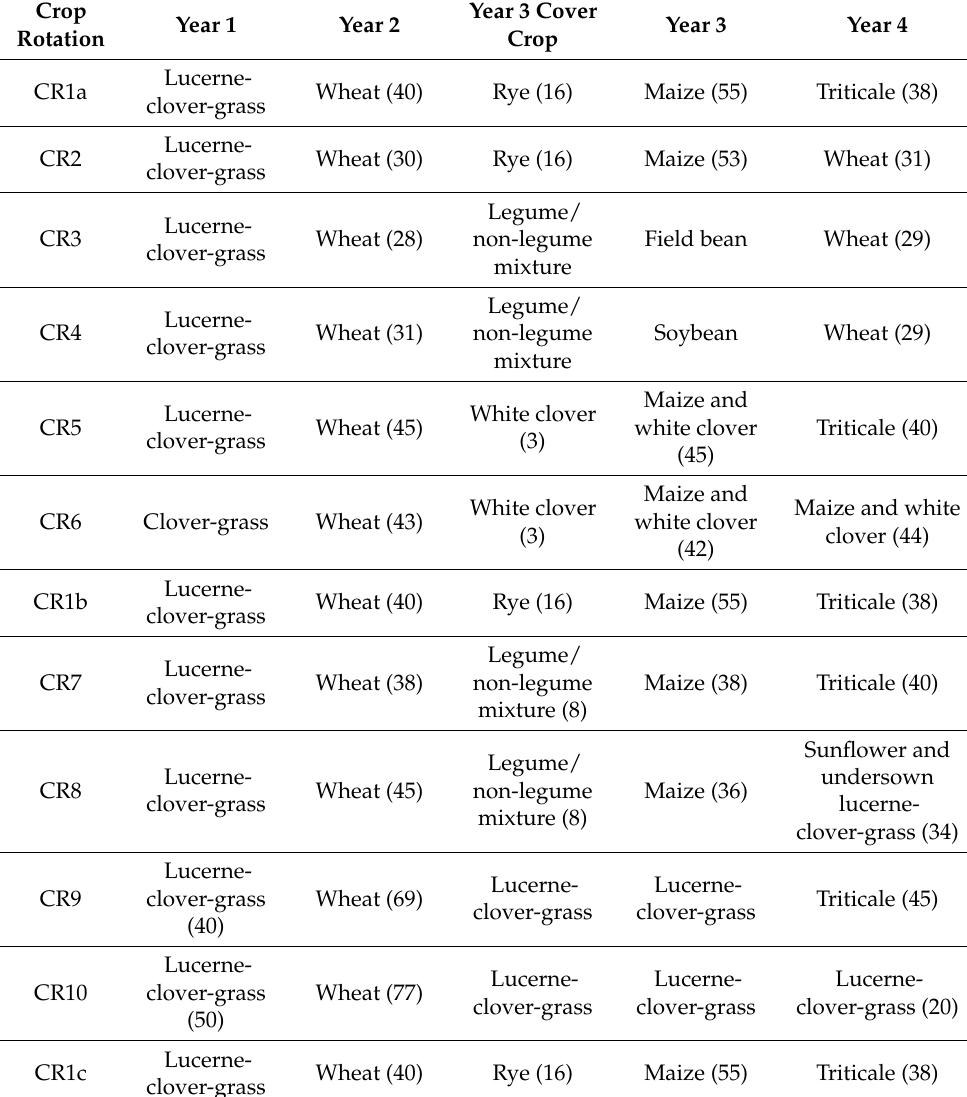
Table 2. Plan of crop rotations and mean amount of digestate fertilised in the fertilised